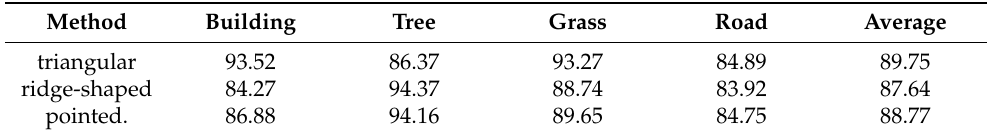
Table 10. Classification result accuracy (%) by single BPA function on test set 1.